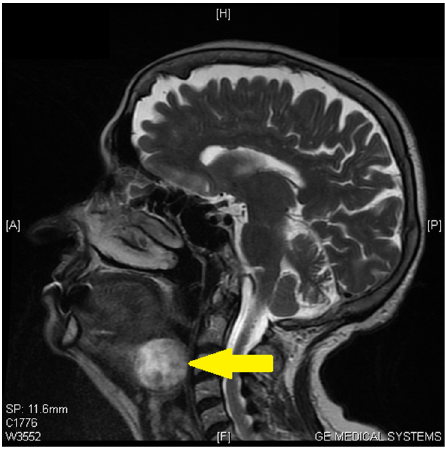
Figure 2. Magnetic Resonance Imaging (MRI) imaging shows a mass in the sublingual region